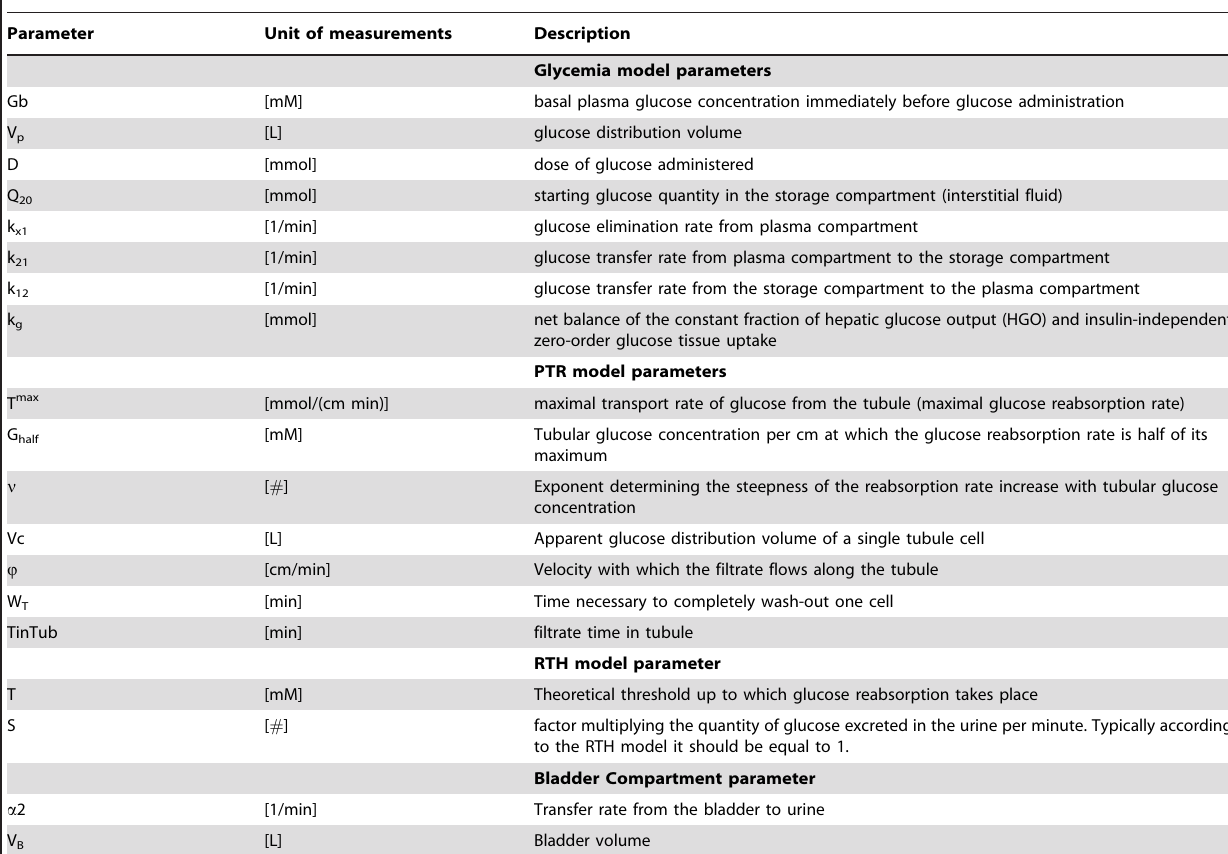
Table 2. Model parameter